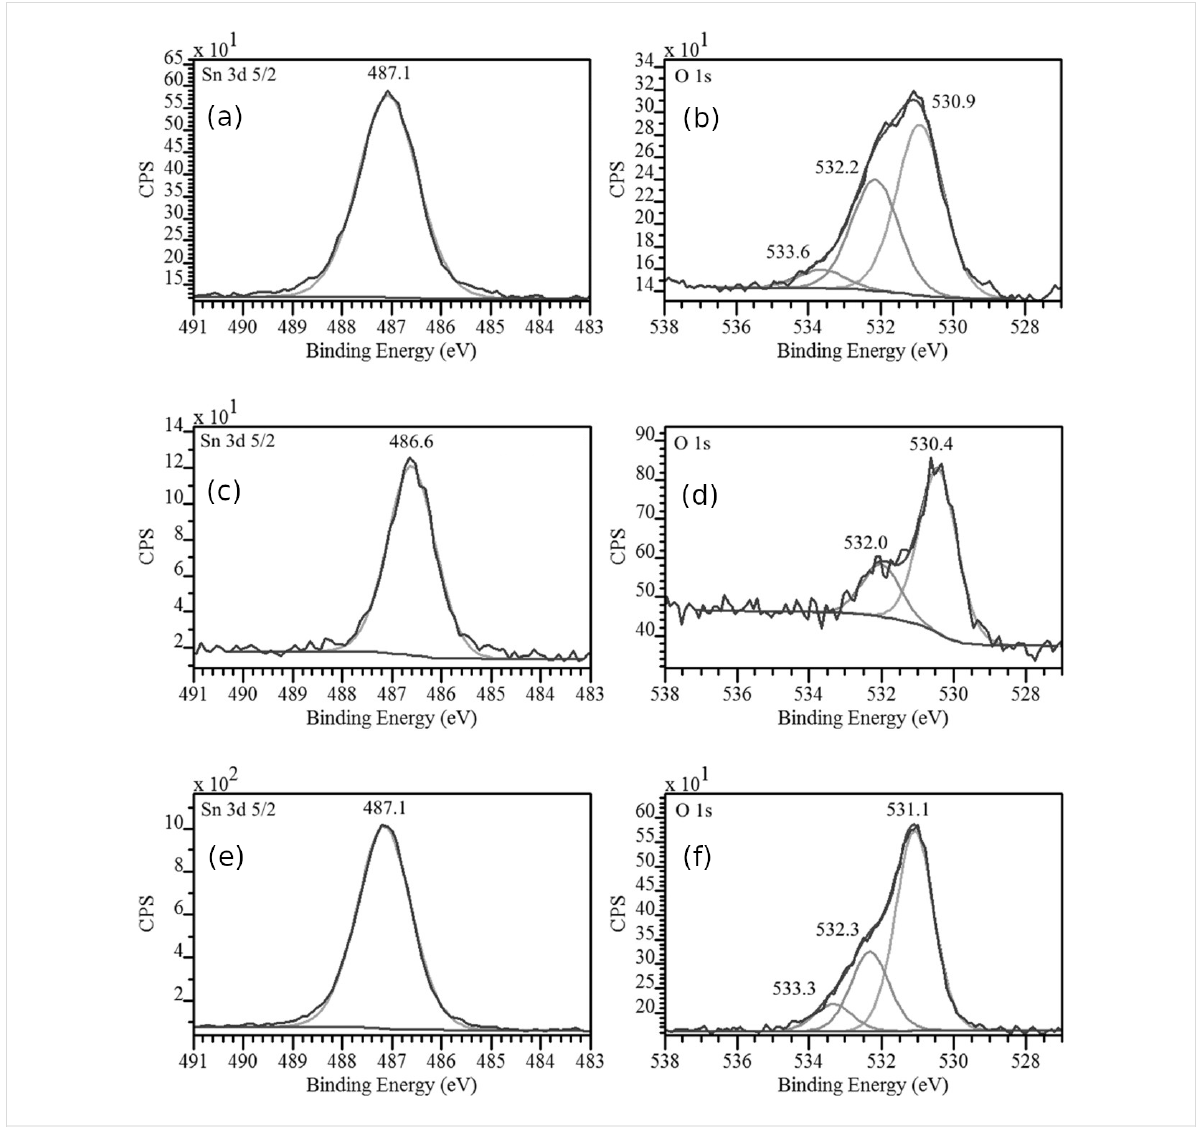
Figure 6: XPS spectra of (a) SnO 2 powder, Sn 3d 5/2 ; (b) SnO 2 powder, O 1s; (c) SnO 2 nanowires, Sn 3d 5/2 ; (d) SnO 2 nanowires, O 1s; (e) SnO 2 sintered lump, Sn 3d 5/2 ; (f) SnO 2 sintered lump, O 1s.